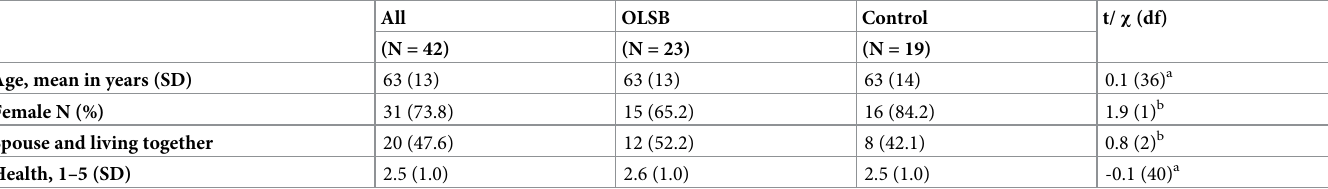
Table 2. Demographical data of informal